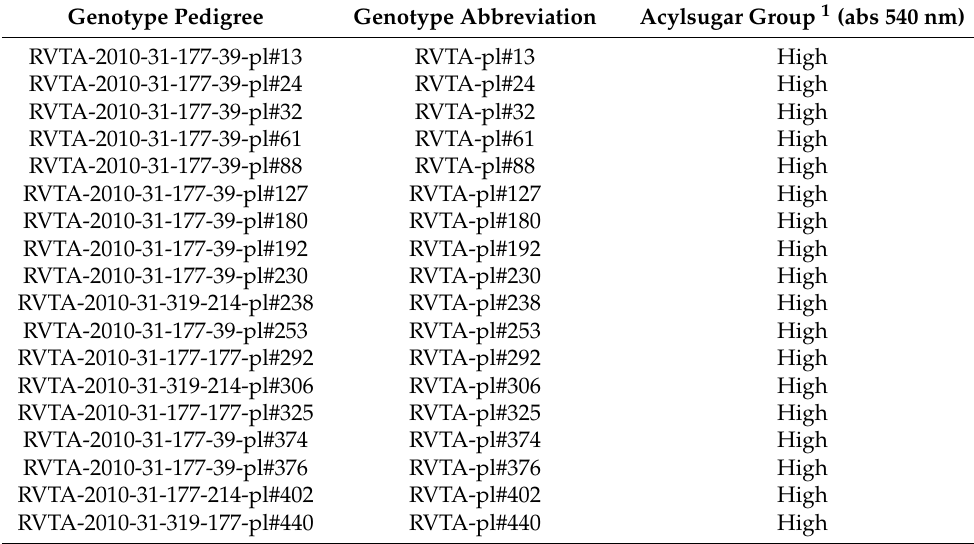
Table 1. List of the selected genotypes divided into two